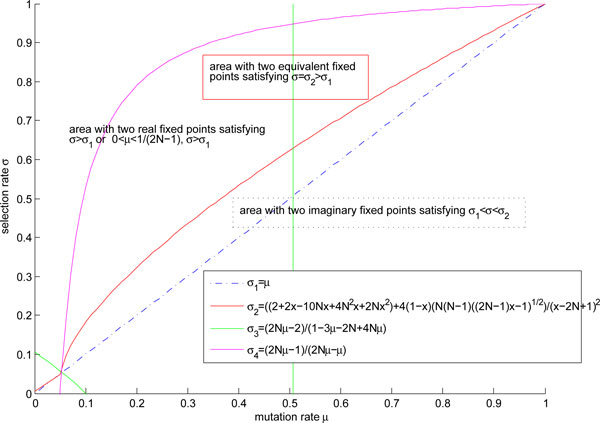
Relation of fixed points and parameters for the system in all regimes. The regime represented by III i) with parameters regions σ ∊ (σ1, σ2) and μ∈(2/(2N-1+2N(N-1)),1) has two imaginary fixed points. The red curve denoted by II) with parameters satisfying σ = σ2 and μ∈(2/(2N-1+2N(N-1)),1) has two equivalent fixed points. The three cases of II) occur in the intervals. The regimes denoted by I) with parameters satisfying σ ∊ (σ2,σ5) and μ∈(2/(2N-1+2N(N-1)),(2N-1)/4N(N-1)); satisfying σ ∊ (σ2, σ5) and μ ∊ ((2N - 1)/4N(N - 1), 1); satisfying σ ∊ (σ 1,σ5) and μ ∊ (0,1/(2N - 1)); satisfying σ ∊ (σ 1,σ5) and μ∈(1/(2N-1),2/(2N-1+2N(N-1))) have two real fixed points. The five cases of I) occur in the regions.